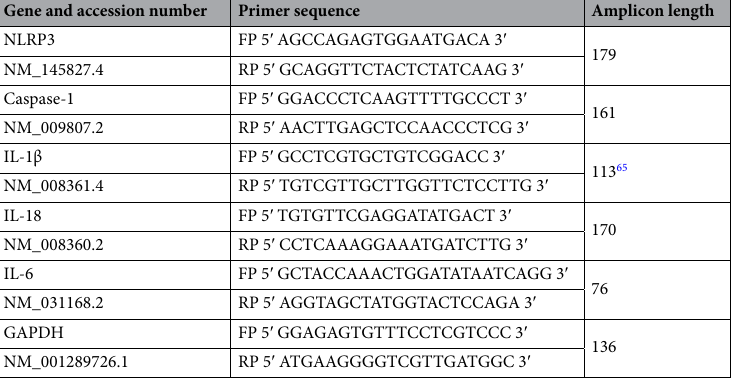
Table 2. List of forward and reverse